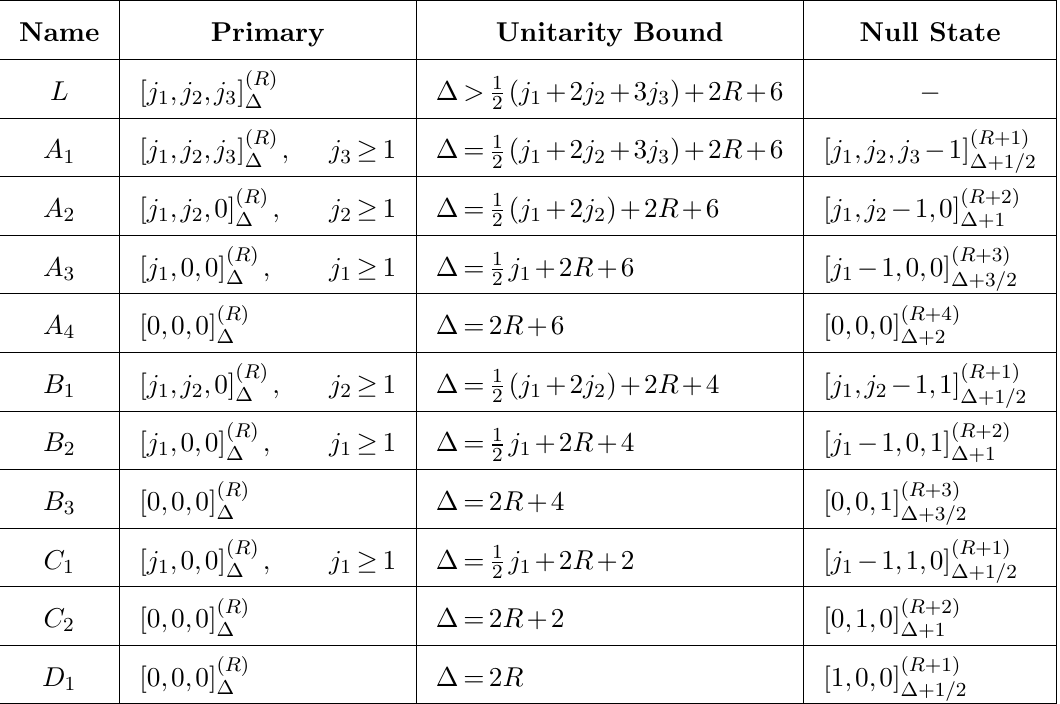
Table 23 . Shortening conditions in six-dimensional N = (1 ; 0)